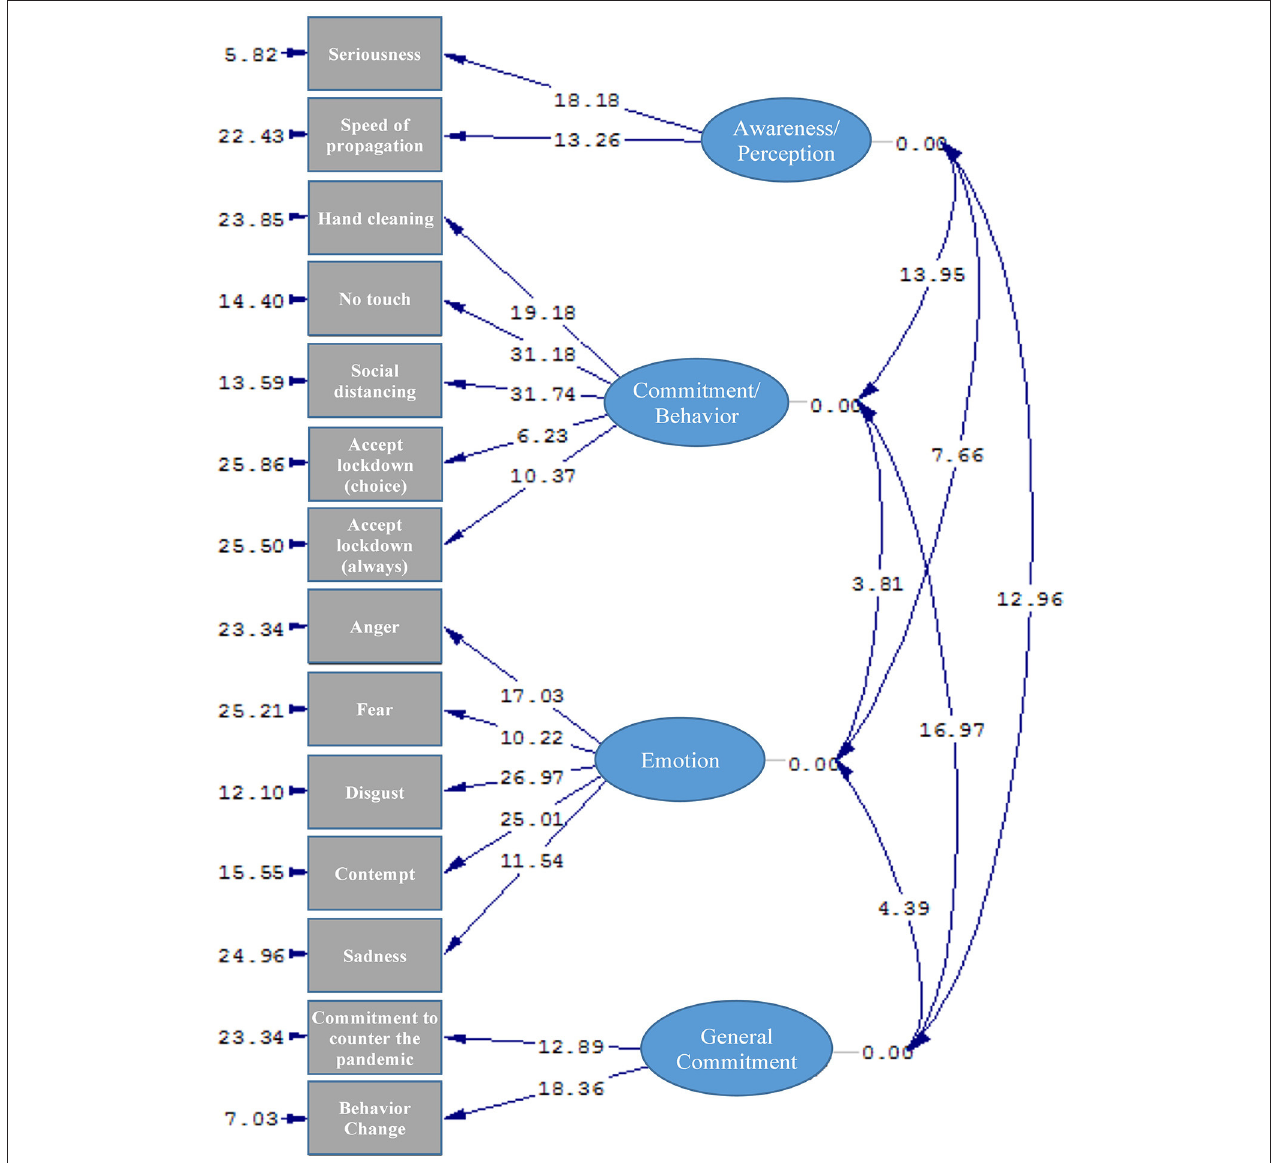
FIGURE 1 | The resulting model ( T -Values) from the CFA analysis ( χ 2 = 968.69; df = 71; p < 0.001; RMSEA = 0.096).